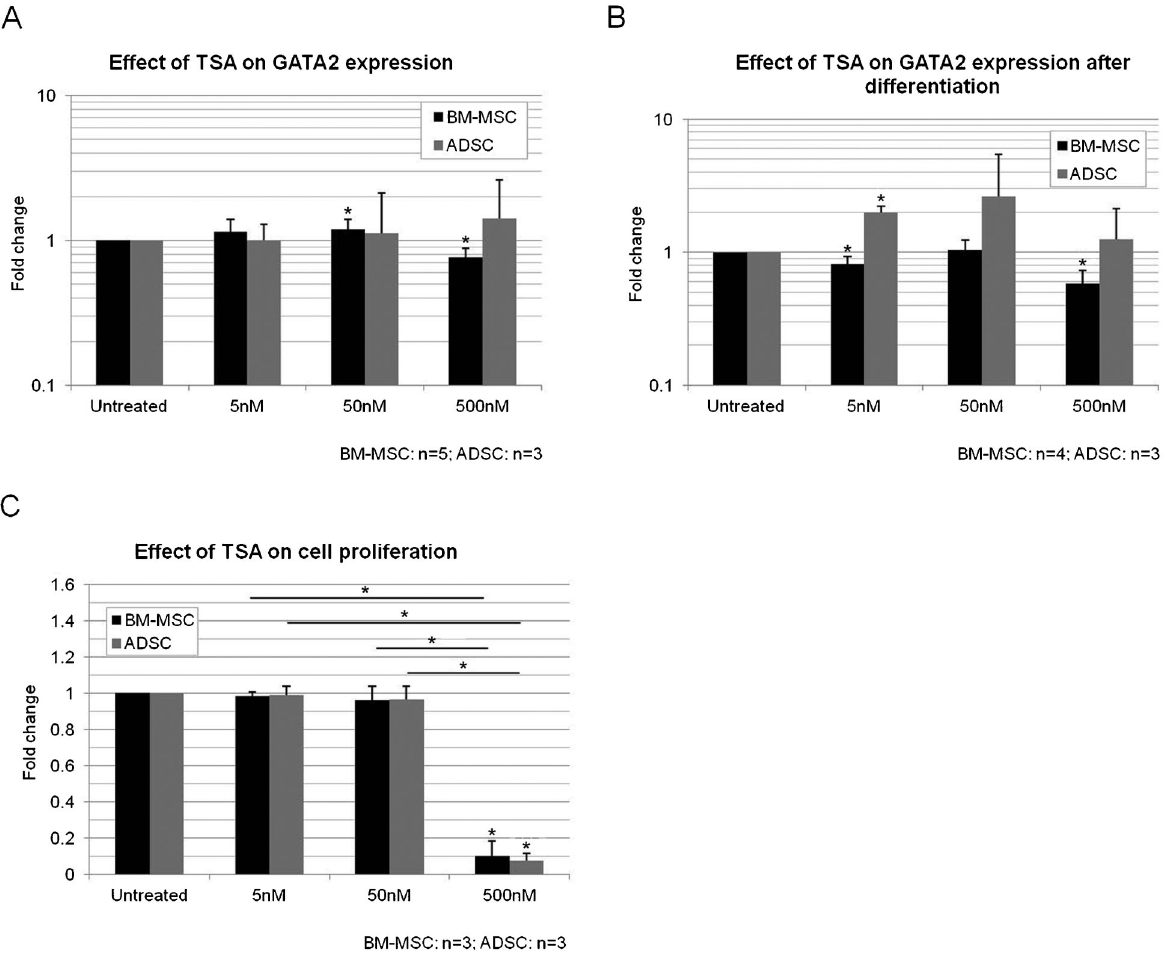
Figure 5. Effect of treatment with TSA (5, 50 and 500 nM) on GATA2 expression and proliferation in MSCs. GATA2 expression in non- induced ( A ) or induced ( B ) cultures treated with TSA. C , Cell proliferation analysis after treatment with TSA. TSA = trichostatin A; MSCs = mesenchymal stem cells; BM-MSCs = bone marrow MSCs; ADSC = adipose tissue stem cells. Data are reported as means ± SD. Asterisks just above SD bars indicate statistically significant differences with respect to untreated cultures of BM-MSCs or ADSCs. *P , 0.05 (Student t